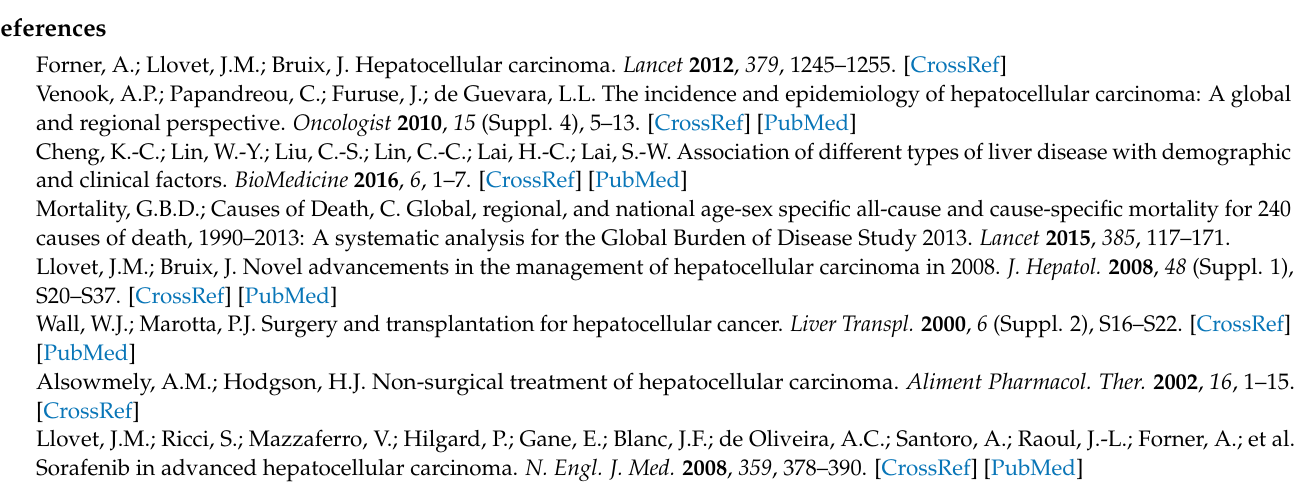
HBV pre-S2 mutant-positive HCC patients; Figure S1: Representative images of PD-L1-expressing cells and Tregs in fluorescent IHC-stained HCC